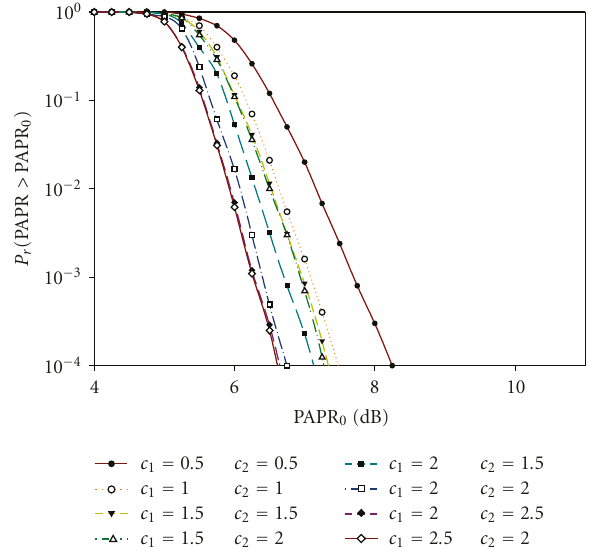
Figure 8: CCDFs comparison of the PSO-based PTS scheme with di ff erent combinations of acceleration constants when N = 128, M = 4, and W = 2. reduction of c 1 = 2 and c 2 = 2; and c 1 = 2.5 and c 2 =